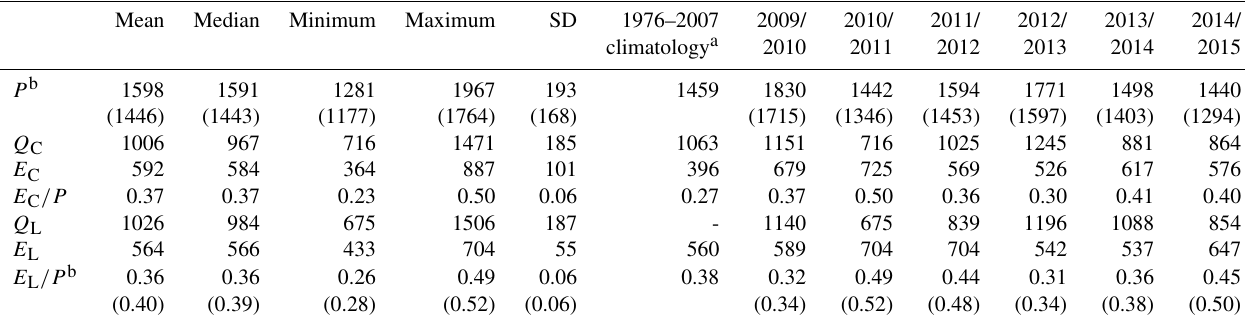
Table 1. Statistical properties of the catchment water balance for the hydrological years (i.e., October–September) 1976/1977 to 2014/2015 and the absolute values for the hydrological years 2009/2010 to 2014/2015. P denotes precipitation, Q C catchment runoff, Q L lysimeter seepage, E C catchment evapotranspiration, and E L lysimeter evapotranspiration. Units in mmyr − 1 (except for E C /P and E L /P , which are